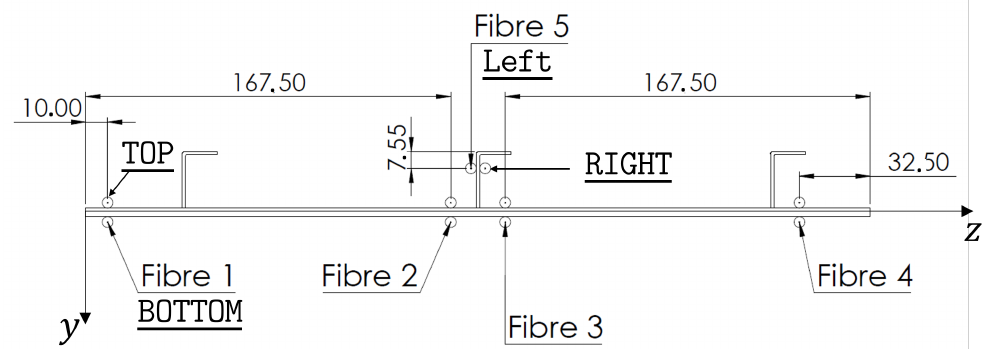
Figure 8. Configuration of the fibre with all dimensions in